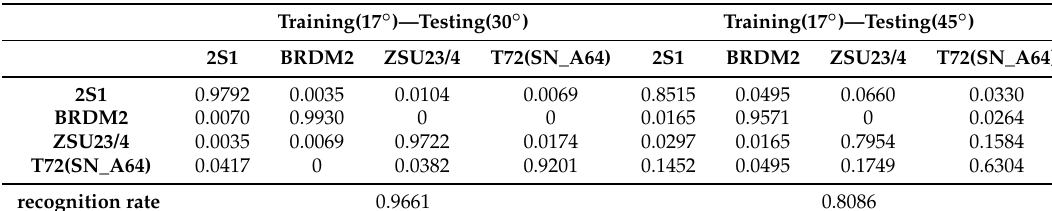
Table 12. The result of SDDLSR based on the SAR-HOG under